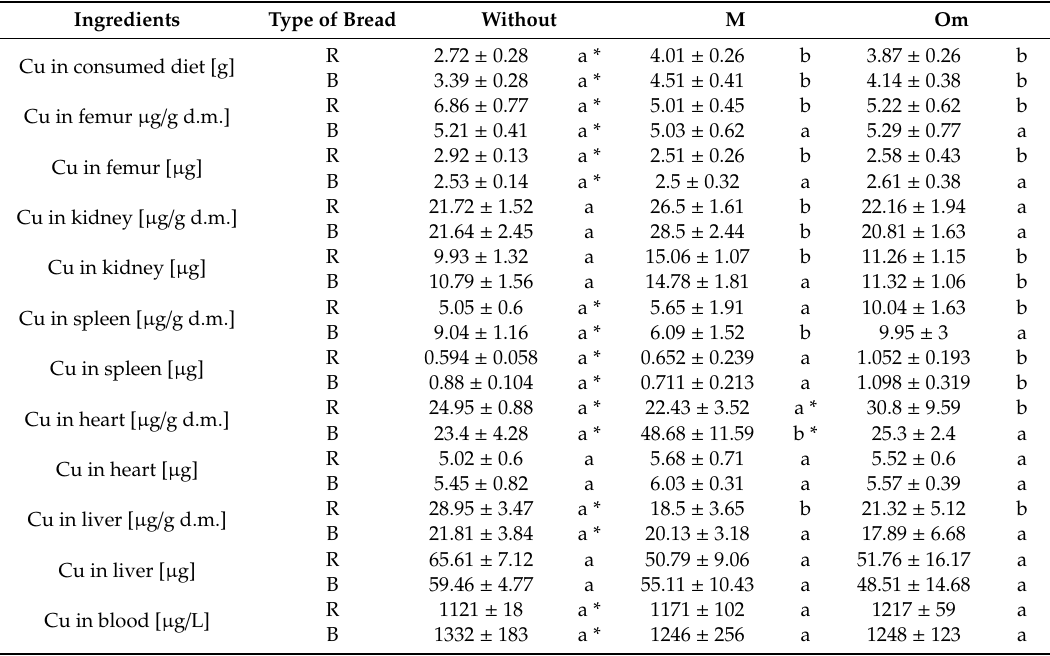
Table 5. Copper content in